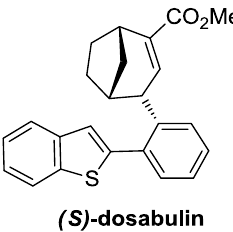
Figure 5. The antimitotic compound, ( S )-Dosabulin, discovered with forward chemical genetics approach